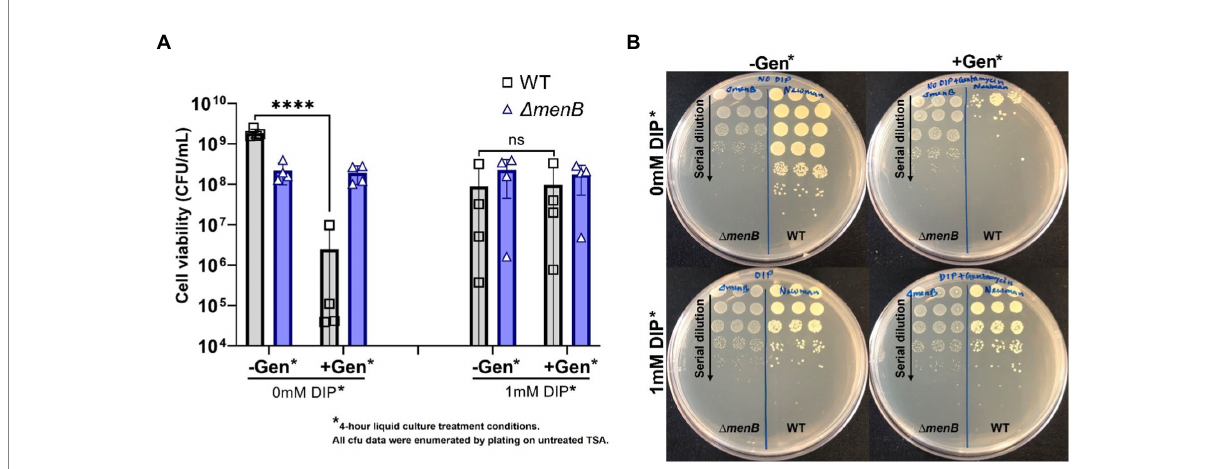
FIGURE 3 Iron restriction enables WT S. aureus to exhibit the aminoglycoside resistance characteristic of the SCV phenotype. (A) WT S. aureus is highly susceptible to gentamicin treatment but becomes equivalently resistant to this antibiotic as a Δ menB strain when iron-restricted with DIP treatment. Each of the data points on the graph represents the average of triplicates on each day and this was repeated for 4 separate days. Error bars represent standard deviation. A one-way ANOVA (Tukey’s multiple comparisons) was applied to understand the statistical significance of the differences (“ **** ” is the indication for p < 0.0001; “NS” is for non-significant data). (B) . The serial dilution plates depict representative CFU data from a single day and were determined by plating onto untreated TSA plates. Treatment conditions listed in the figure represent the conditions from the 4 h incubation period prior to plating on untreated TSA plates for CFU